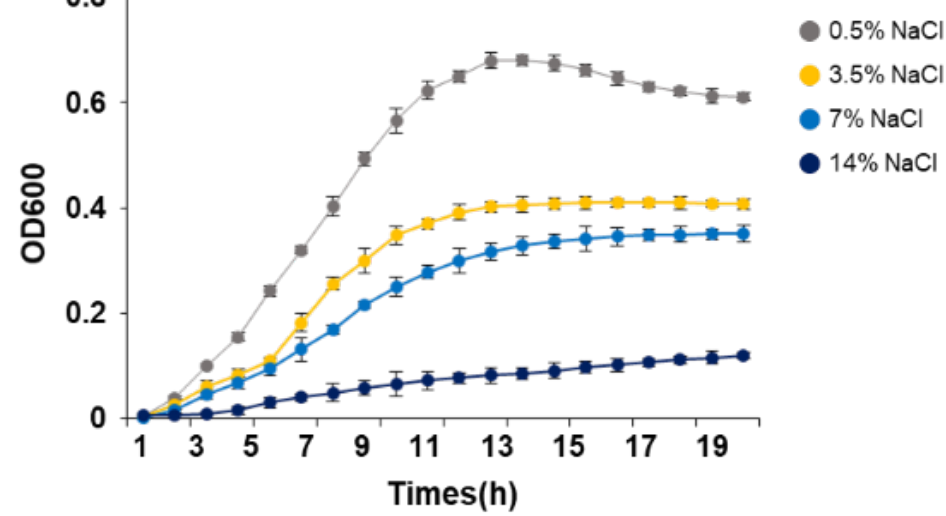
Figure 1. Growth of Staphylococcus equorum strain KM1031 at different NaCl concentrations. Three independent replicates were performed, the average values and standard error means were used to draw the curves.